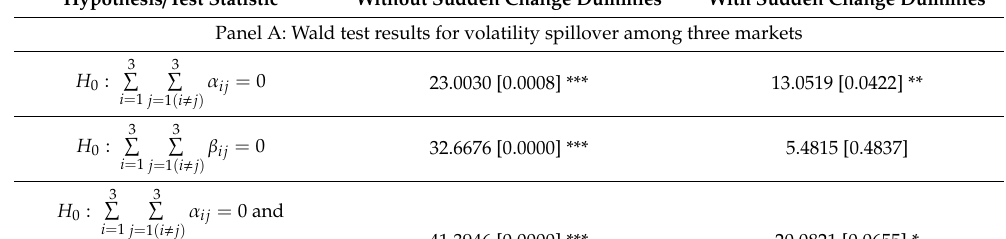
Table 7. Wald test for dynamic volatility spillover among the EUA, Biofuel, and Brent oil returns. Hypothesis / Test Statistic Without Sudden Change Dummies With Sudden Change